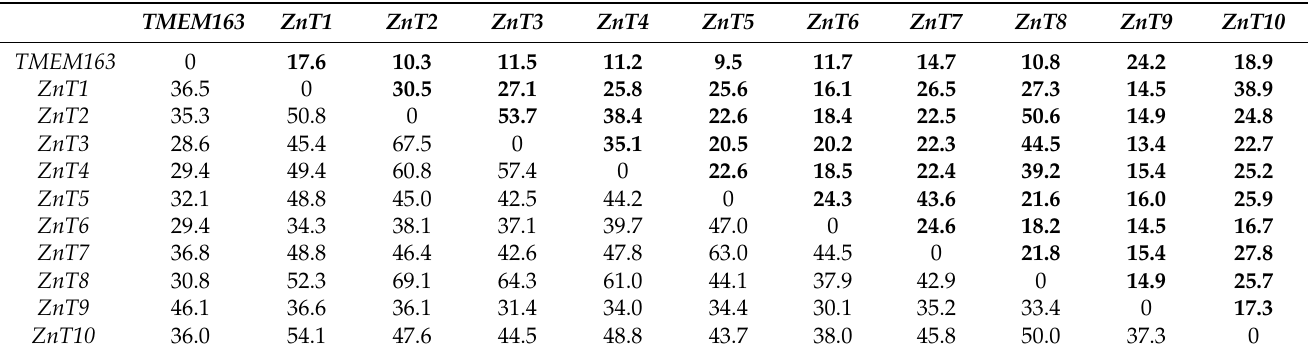
Table 1. Multiple sequence analysis of TMEM163 and ZnT protein family using Clustal Omega (MegAlign Pro, Lasergene v17.1). Percent identity and similarity are shown by the upper right values (bold text) and lower left values (regular text), respectively. The identity percentage signifies the number of amino acids that exactly matches sequences between two proteins, while similarity percentage represents the likelihood that the two proteins have evolved from a common ancestral protein. MegAlign Pro calculated the numerical values with the following parameters: distance metric = Uncorrected Pairwise; Gap treatment = Pairwise gap removal; Residues considered =